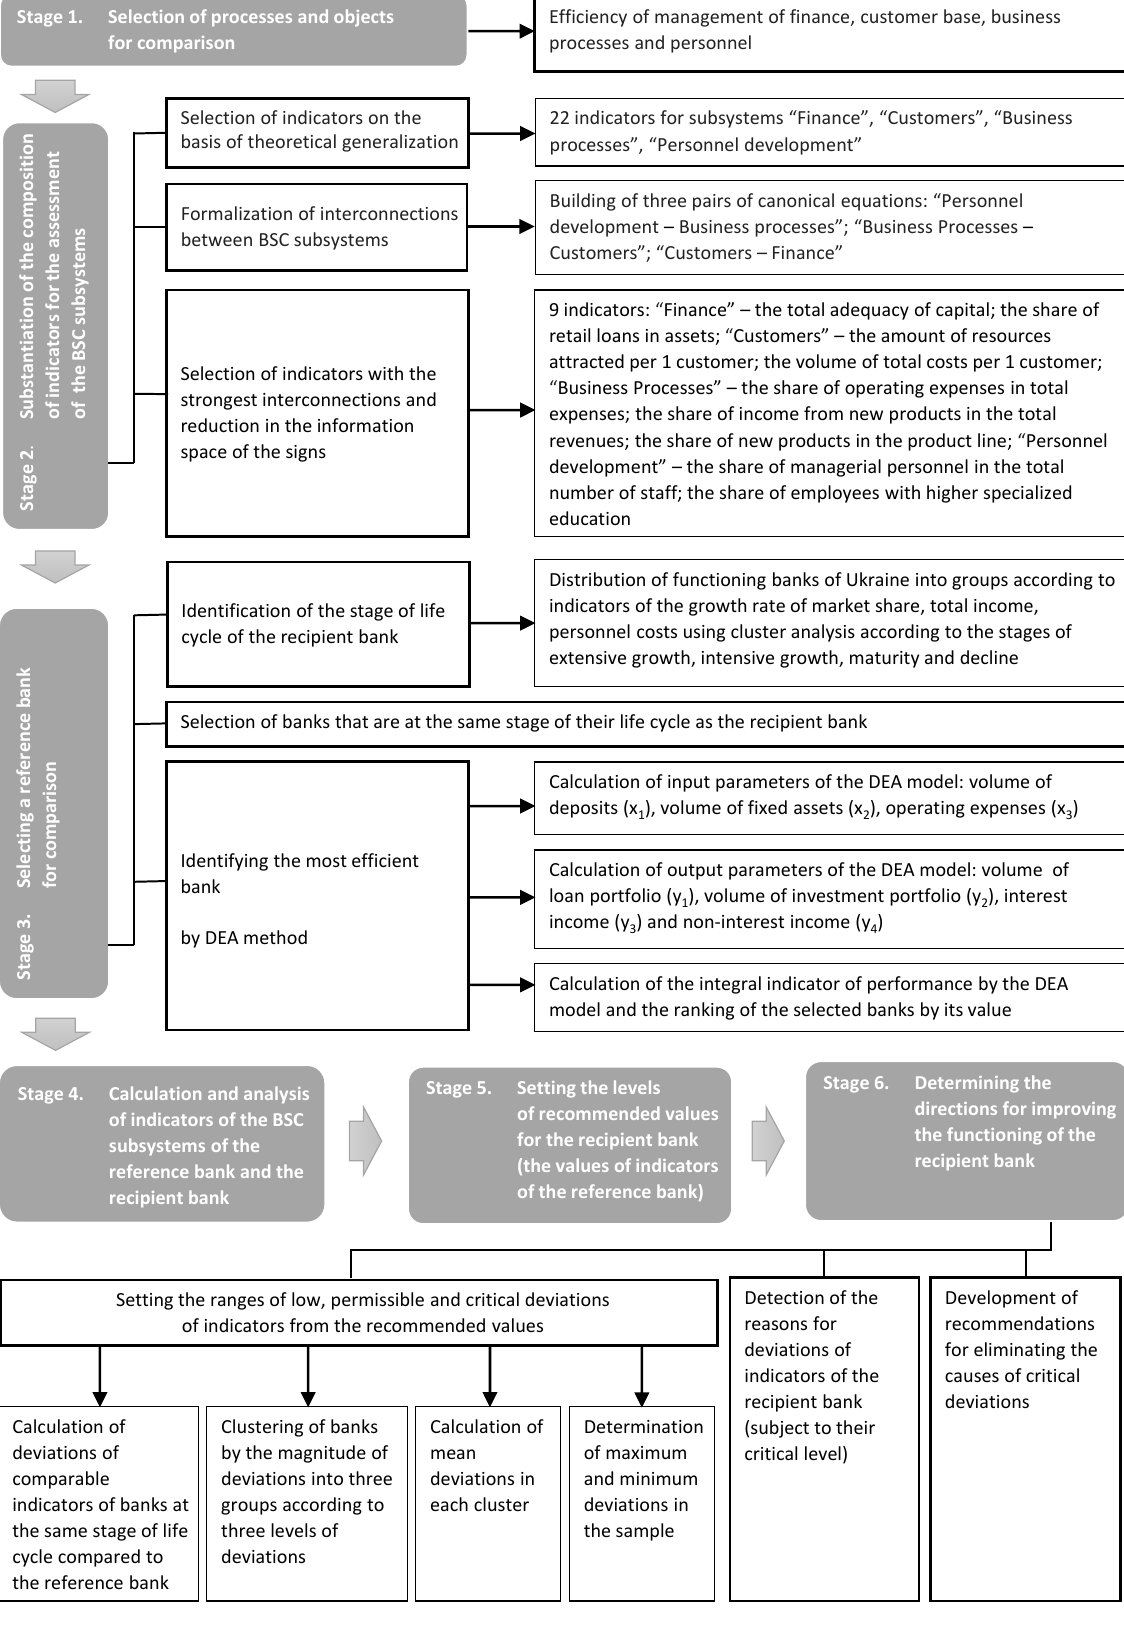
Figure 1. The sequence and content of the stages of benchmarking relating to the performance of